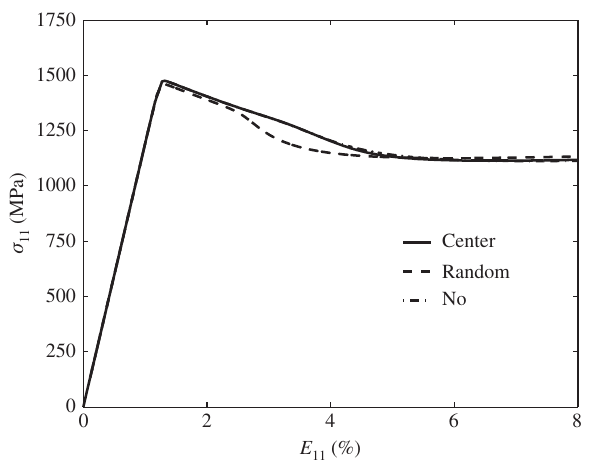
Figure 18 Sample S , variation of initial defect: average stress 2 component | σ | over applied strain | E | under tensile loading for dif- 11 11 ferent conditions for the initial defects within the sample. Solid line, one element with defect placed near the center; dashed line, results with randomly distributed defects; dot-dashed line, no defect placed in the